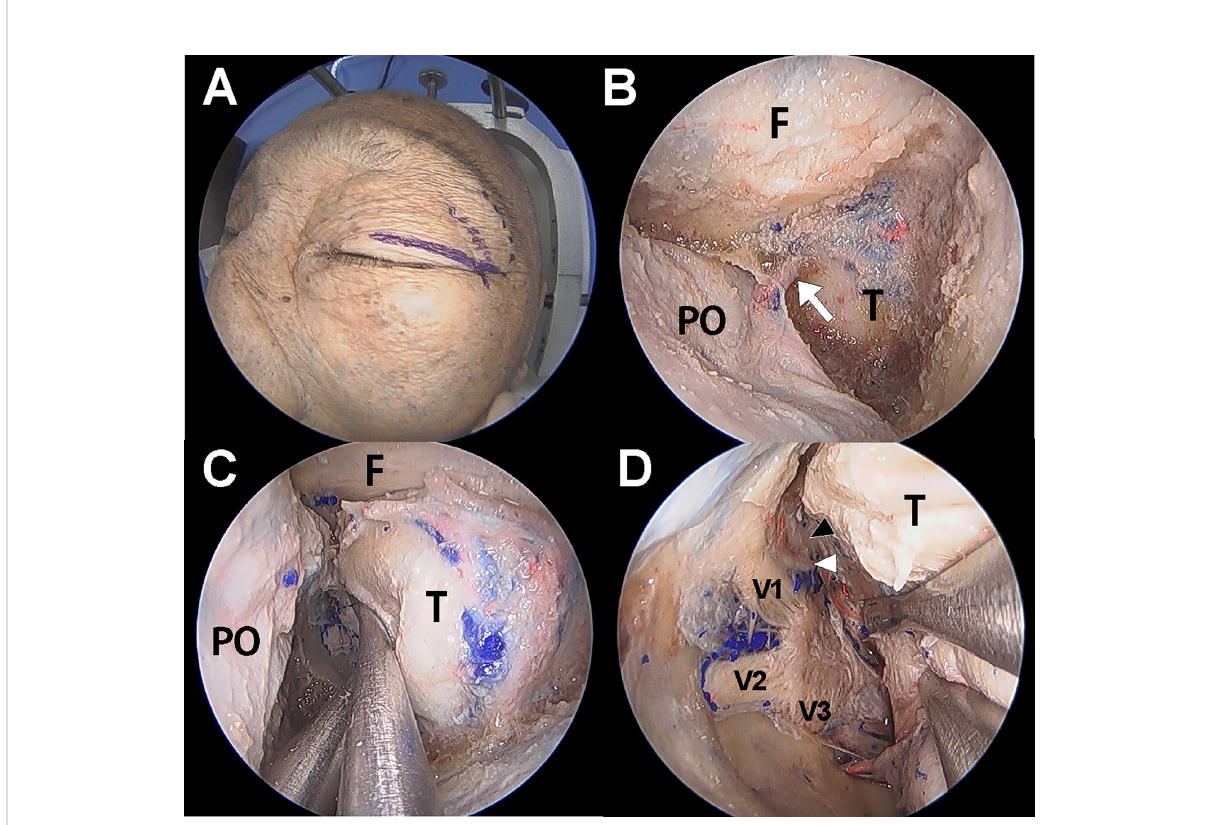
FIGURE 2 Cadaver demonstration showing the endoscopic transorbital approach (ETOA) to cavernous sinus (CS). (A) Superior eyelid incision was made on the superior eyelid with lateral extension. (B) After greater and lesser wing of sphenoid was drilled out, frontal and temporal dura was exposed. Meningoorbital band (white arrow) was identi fi ed and cut. (C) Then, the orbital contents and temporal dura were more retracted medially and laterally, respectively. (D) After fi ne interdural dissection with temporal lobe retraction, the entire lateral wall of CS was exposed in which oculomotor nerve (black arrowhead), trochlear nerve (white arrowhead), trigeminal nerve and its branches are identi fi ed. F, frontal dura; T, temporal dura; PO, periorbita; V1, ophthalmic branch of trigeminal nerve; V2, maxillary branch of trigeminal nerve; V3, mandibular branch of trigeminal